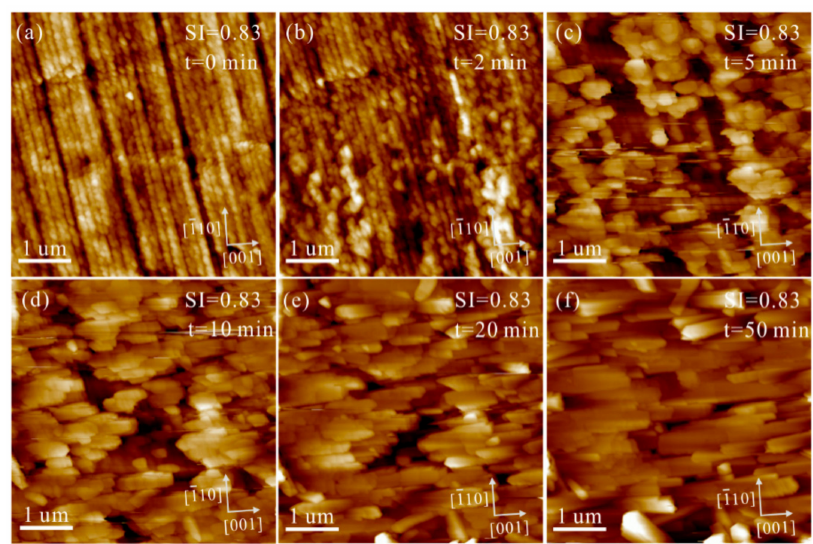
Figure 5. AFM height images of the polished aragonite (110) surface in solution (Mg 2 + / Ca 2 + = 0, SI calcite = 0.83) under flowing conditions at pH = 8.0 ± 0.1 for ( a ) 0, ( b ) 2, ( c ) 5, ( d ) 10, ( e ) 20 and ( f ) 50 min. SEM was used to observe aragonite (110) surfaces after the heterogeneous nucleation and growth of CaCO 3 in solutions with di ff erent SI calcite . The size and morphology of these crystals are identical, while the orientation of crystals in the lower and upper layers is disparate. Crystals in the lower layer have their c axes parallel to aragonite (110) substrates, whereas those in the upper layer have their c axes perpendicular to the substrates (Figure 6). The surfaces of these crystals are generally smooth, only with local cracks and holes (as indexed by the red arrows in Figure 6f,h). In addition, nanoparticles are observed from the broken parts and a few crystal surfaces (as indexed by the red arrows in Figure 6e,f).